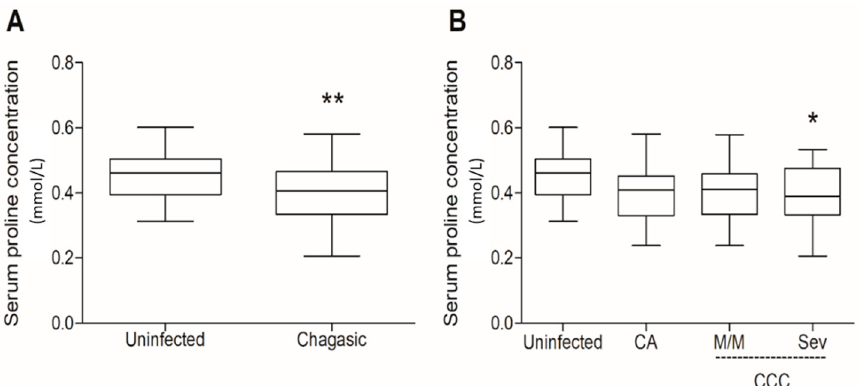
Figure 1. Serum proline in chagasic subjects. Serum samples were obtained from healthy and T. cruzi -infected patients from the Hospital Provincial del Centenario de Rosario (Rosario, Argentina). ( A ) All chagasic subjects ( n = 83) were grouped and compared to uninfected healthy controls. ( B ) Chagasic subjects were divided into CA ( n = 27), M / M ( n = 26), and Sev ( n = 30) groups and compared to controls. The control uninfected group was composed by T. cruzi -seronegative subjects ( n = 29). The samples were submitted to a colorimetric test which uses the ninhydrin as proline marker (see Materials and Methods). The reading was carried out at 515 nm in a spectrophotometer. CCC, chronic chagasic cardiomyopathy; CA, chronic asymptomatic; M / M, mild and moderate; Sev, severe. Box plots show median values, 25–75th percentiles, and maximum and minimum values of the data from each group. The statistics were obtained by T-test ( A ), one-way ANOVA, and Tukey’s multiple comparison test ( B ), with di ff erences being regarded as statistically di ff erent when p < 0.05. * p < 0.05; ** p <0.01